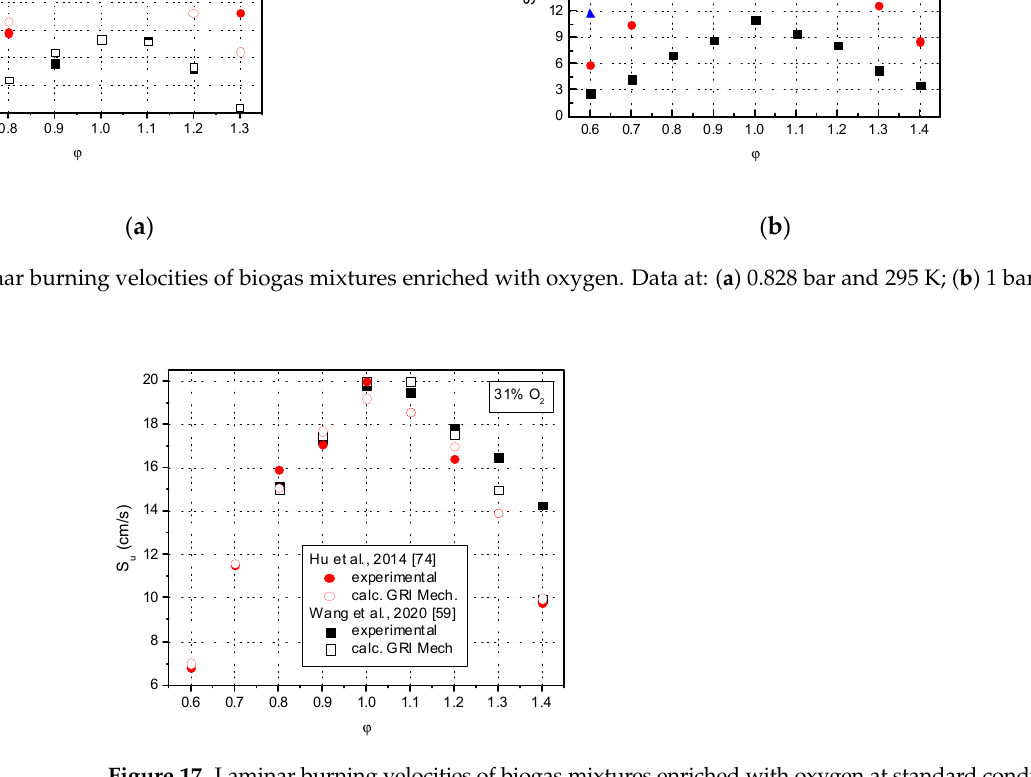
Figure 17. Laminar burning velocities of biogas mixtures enriched with oxygen at standard